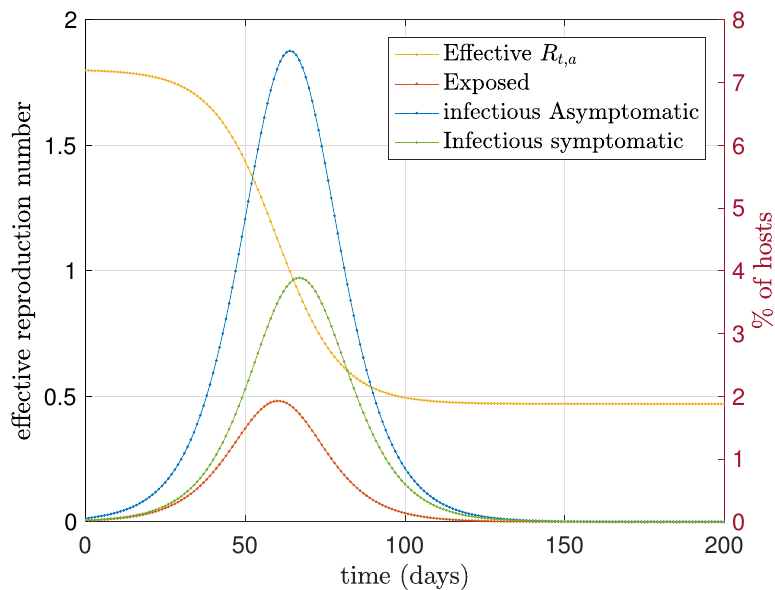
Figure 2. Progression over time of the percentage of hosts in each infected stage E t , A t , I t , t ≥ 0 (right axis) and the effective reproduction number R t , a —see (9) (left axis) giving the transmission potential of the disease at the t -th day. Size of the peaks: E 60 = 1.93%, A 64 = 7.5%, I 67 = 3.89%. Parameter values: α → 1, incubation period 1/ α + 1/ δ = 5 days, infectious period 1/ δ + 1/ γ = 7 days, probability of developing symptoms p = 0.7, virulence q γ = 6.6%, transmission rates β 1 = 0.75 δ and β 2 = 0.5, and basic reproduction number R 0, a = 1.8—see